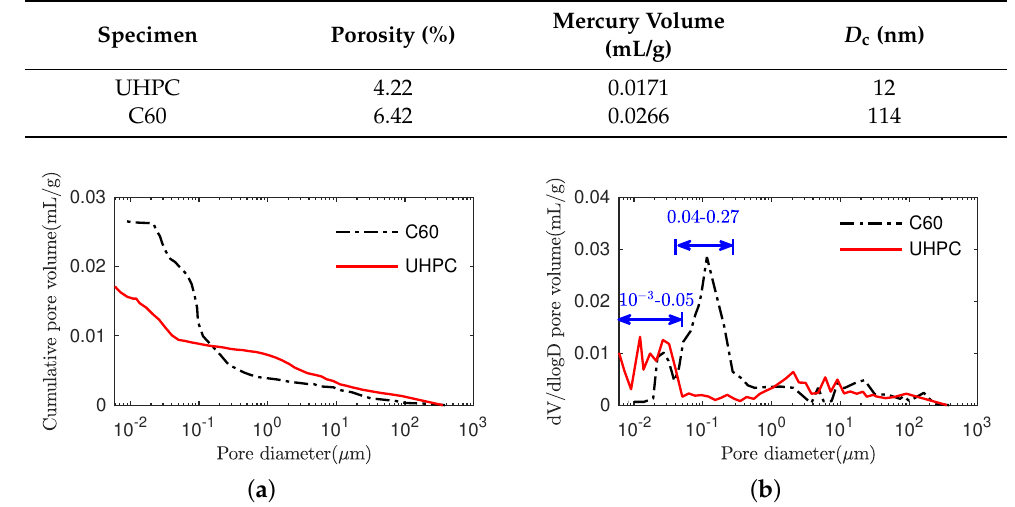
Table 8. Porosity, total intruded mercury volume, and critical pore size.